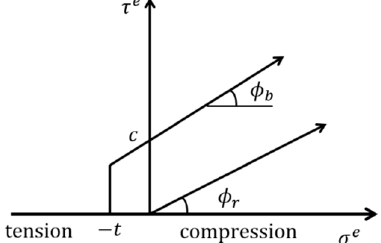
Figure 2. Failure envelopes for bonded element and unbonded element [39]. (Note tension is negative and compression is positive in this study).